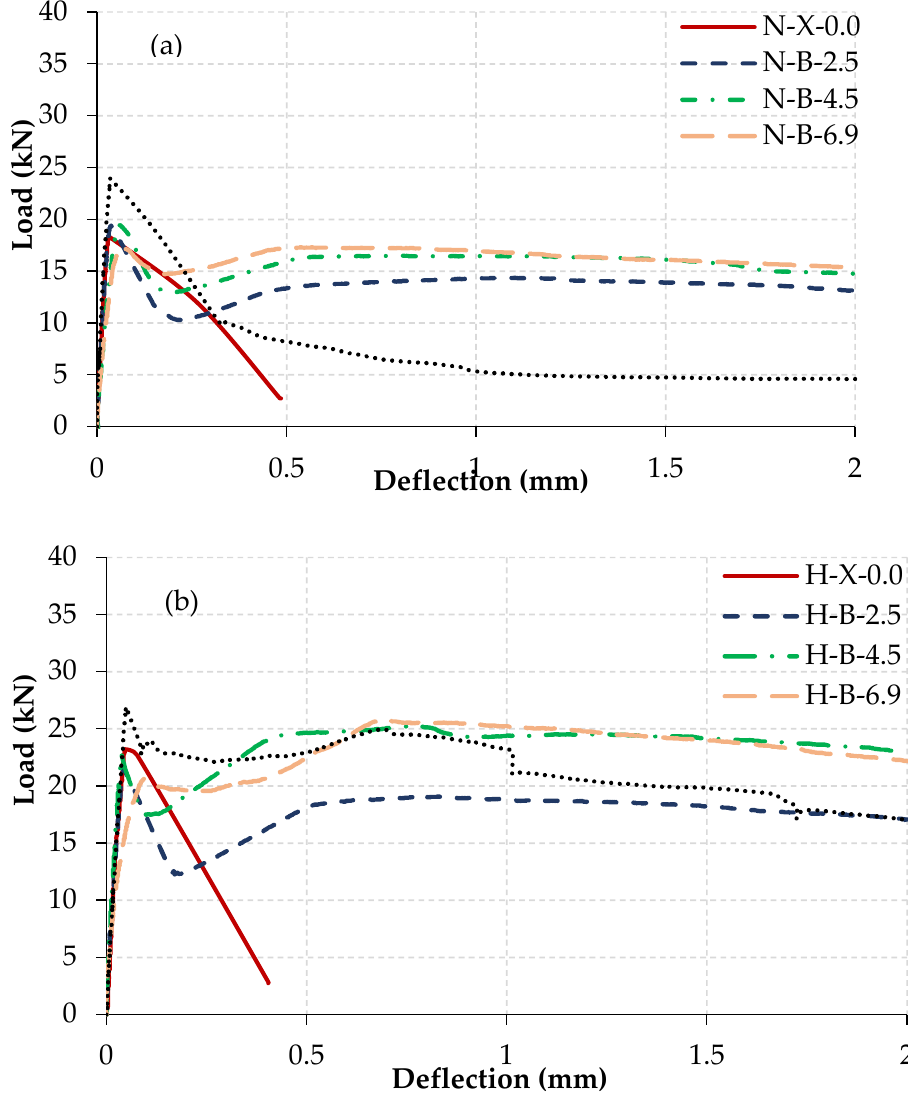
Figure 4. Load–deflection (P- δ ) curves for layered specimens: ( a ) N composites, and ( b ) H composites. After the first cracking, the prisms did not fail but continued to carry either decreasing loads (N-B-2.5, N-B-4.5, N-B-6.9, N-S-1.0, H-B-2.5, and H-S-1.0) or increasing loads (H-B-4.5 or H-B-6.9). The post-cracking behavior of the former prisms was associated with a sudden drop (an average drop of 30% at approximately 0.2 mm deflection) in the load.